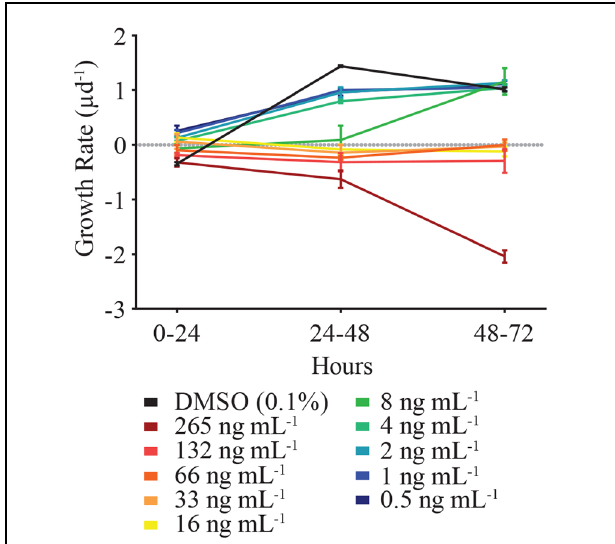
FIGURE 4 | The incremental growth rate ( µ d − 1 ) of E. huxleyi (strain 624) over the experimental time period. At toxic concentrations (between 8 ng mL − 1 and above), E. huxleyi growth rate remained relatively consistent among the time periods examined. Thus, the presence of HHQ results in static E. huxleyi growth rather than cell lysis. Error bars are one standard deviation of the